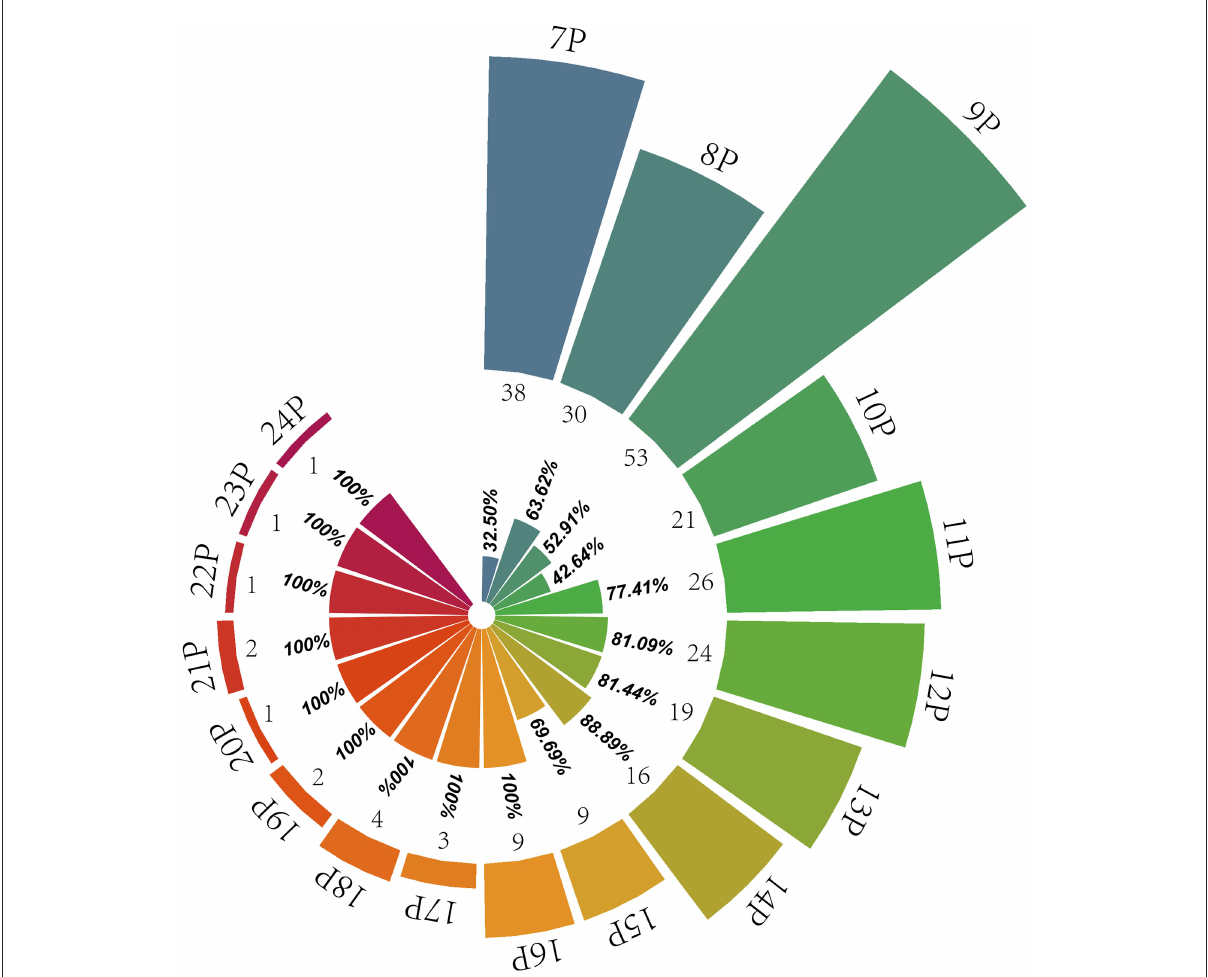
FIGURE2 Distribution of pleasant taste peptides in the fermentation mycelium of S. rugosoannulata . 7P-24P stands for heptapeptides to 24 peptides; the internal rose chart shows the MS area proportion of salty and umami peptides in their respective peptides (32.50% − 100%), and the external rose chart shows the numbers of pleasant taste peptides